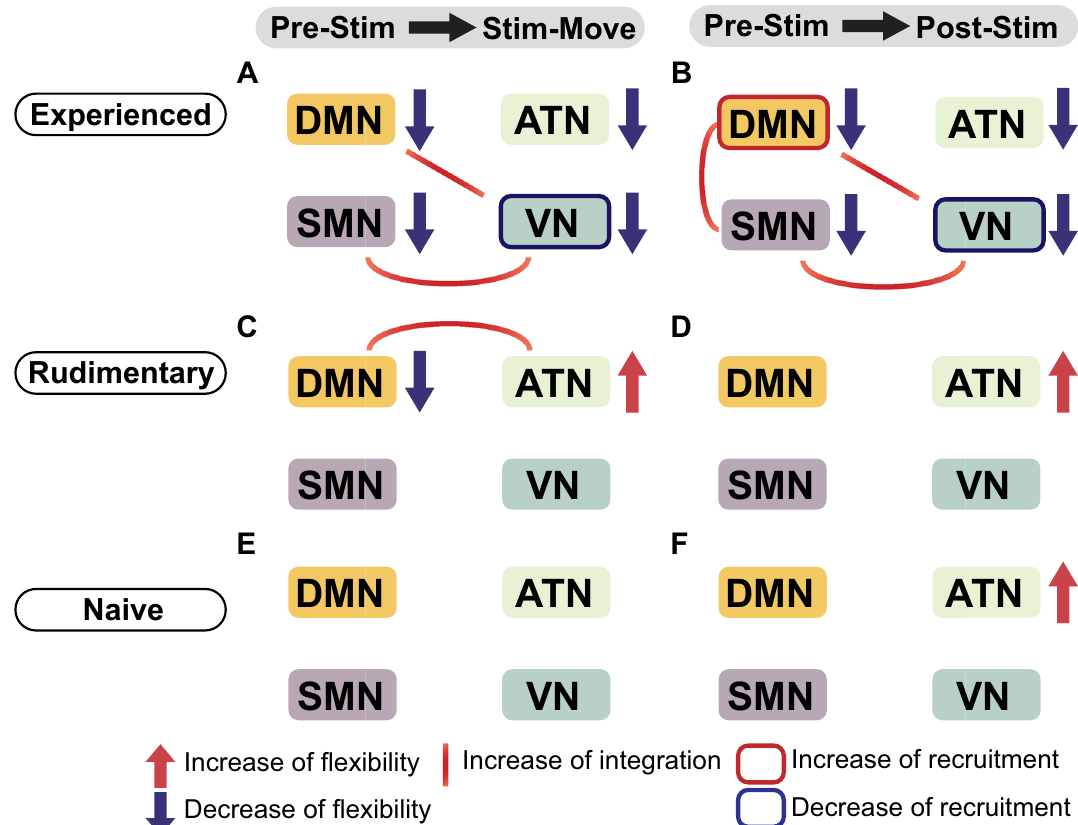
Figure 8. Summary schematic of statistically significant changes in flexibility , integration , and recruitment for participants with upper limb amputations. ( A ) For A01 who had extended experience with tTENS, comparison between Stim-Move and Pre-Stim shows decreased flexibility of all four large-scale systems, increased integration between SMN and VN, and between DMN and VN. VN shows decreased recruitment . ( B ) Comparison between Post-Stim and Pre-Stim for the experienced participant shows decreased flexibility of all four large-scale systems, increased integration between SMN, DMN, and VN. Recruitment of VN decreases. ( C ) For A02 who had limited experience with tTENS, comparison between Stim-Move and Pre-Stim shows decreased flexibility of DMN, increased flexibility of ATN, and increased integration between DMN and ATN. ( D ) Comparing Post-Stim with Pre-Stim for the less experienced (rudimentary), ATN shows increased flexibility . ( E )–( F ) For A03 who had no experience with tTENS (naive), comparison between Post-Stim and Pre-Stim shows increased flexibility of